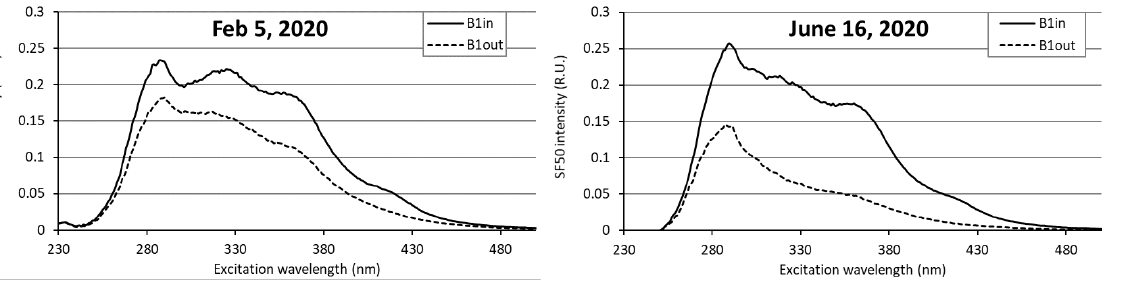
Figure 7. Synchronous fluorescence spectra in winter (5 February 2020) and summer (16 June 2020)